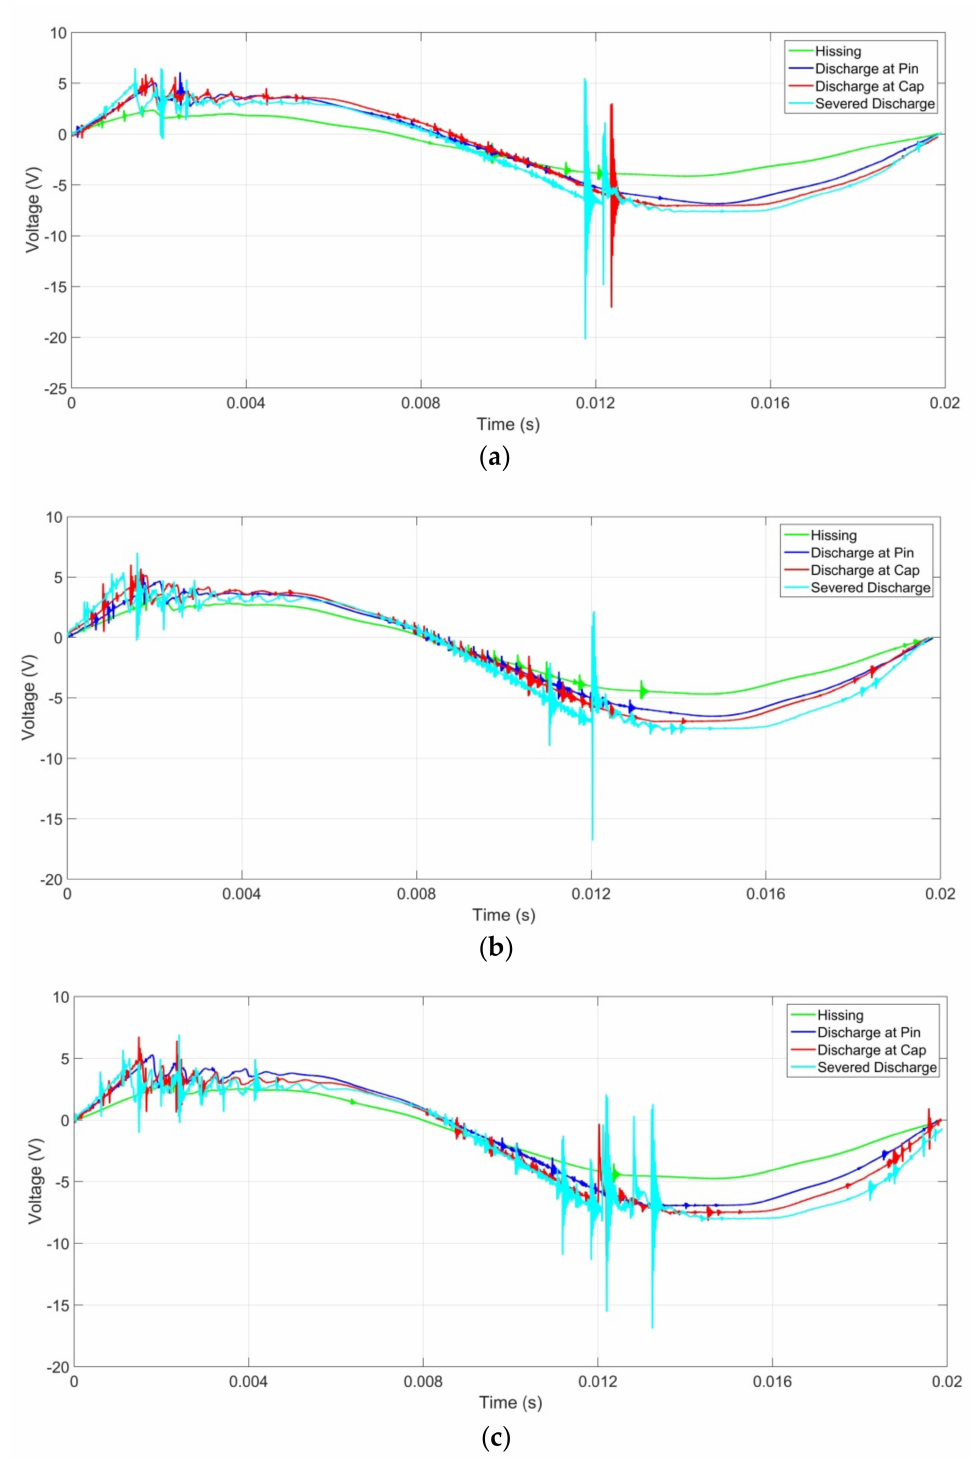
Figure 6. UV signal for insulator samples at light contamination level with insulator ages